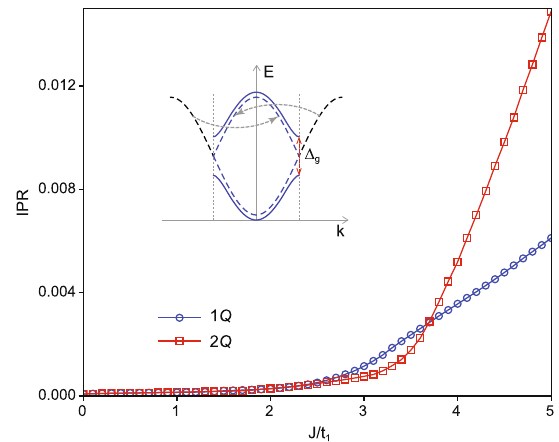
Fig. 4 Inverse participation ratio of CeAuSb 2 . Inverse participation ratio (IPR) averaged over all the eigenvalues at 1 Q (circles) and 2 Q (squares) states. Error bars are smaller than the size of the data points. Inset illustrates the band folding and gap opening at the Brillouin zone boundary in the presence of a commensurate spin texture.